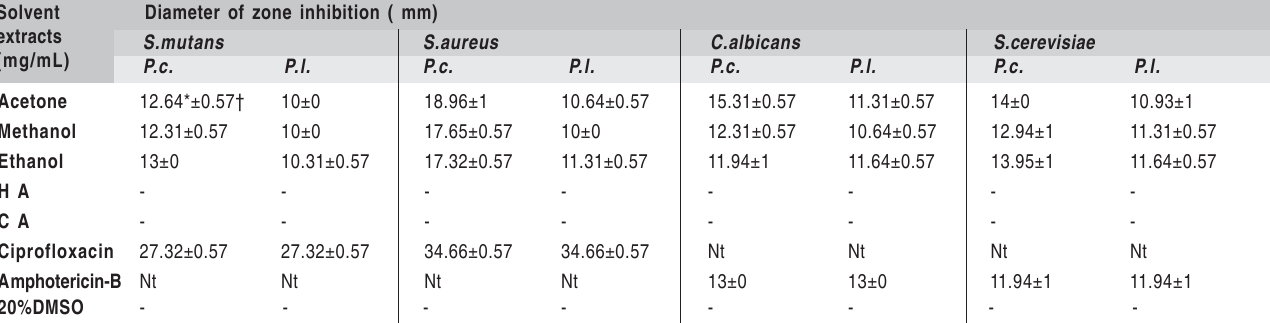
(-) = no activity, nt = not tested, P.c . = Piper cubeba, P.l. = Piper longum, HA= Hot aqueous extract, CA= Cold aqueous extract, Data shown as * Values, including diameter of the well (8 mm), are means of three replicates ± † Standard deviation, P = 0.001 indicates significantly different from control; Dennett’s t -test after analysis of